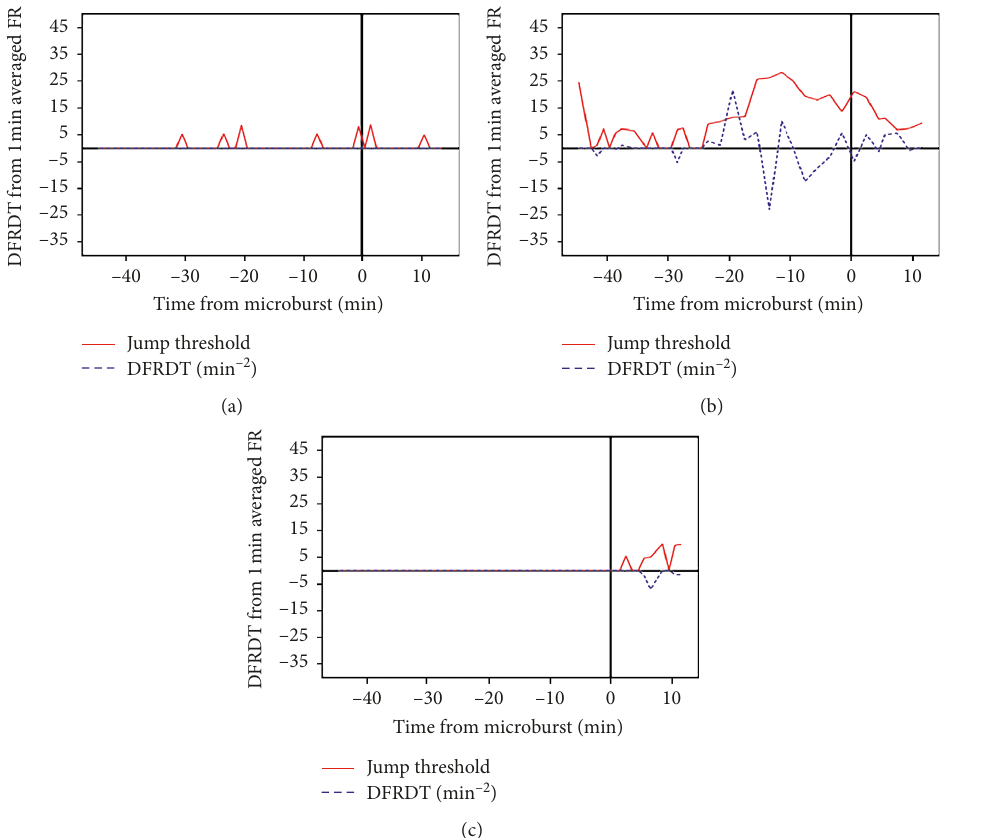
Figure 7: As in Figure 6, but for the last three microburst cases. (a) 20150803 total lightning. (b) 20160616 total lightning. (c) 20160701 total